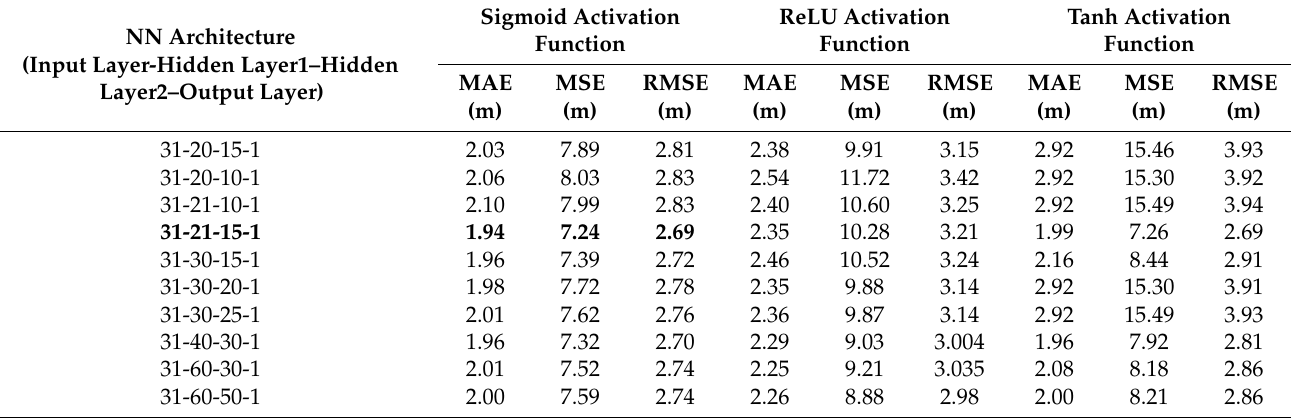
Table 2. Value of Loss parameters for different activation functions in several iterations for Gha- ziabad and surrounding regions (Plain Terrain) .